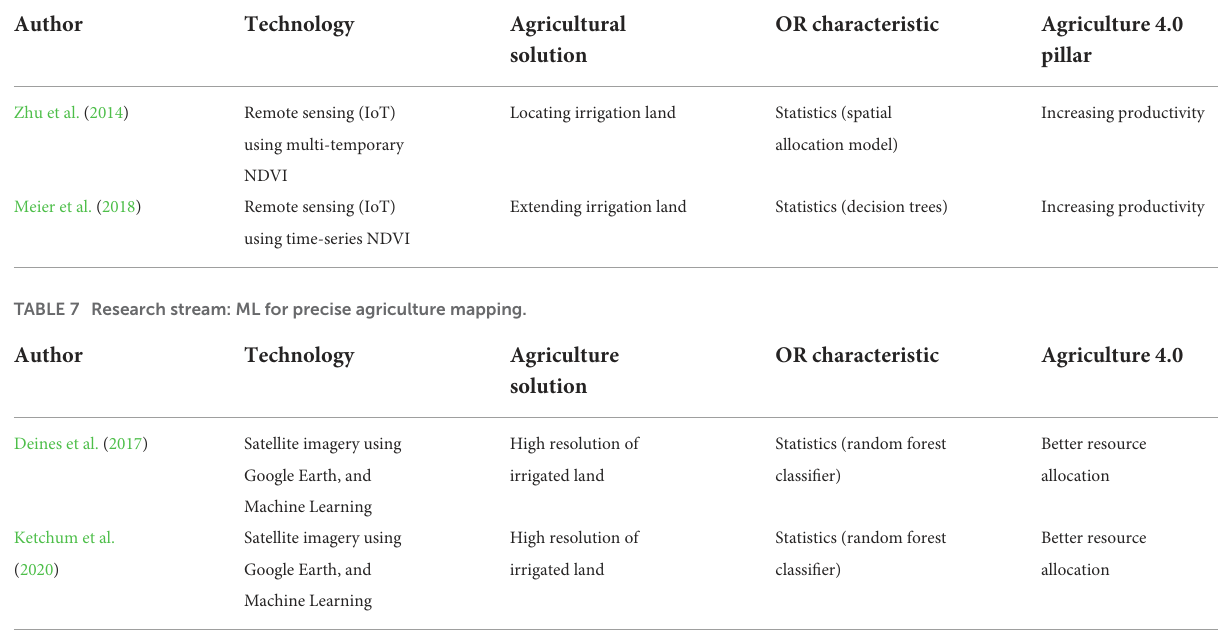
TABLE 6 Research stream: remote sensing and statistics.